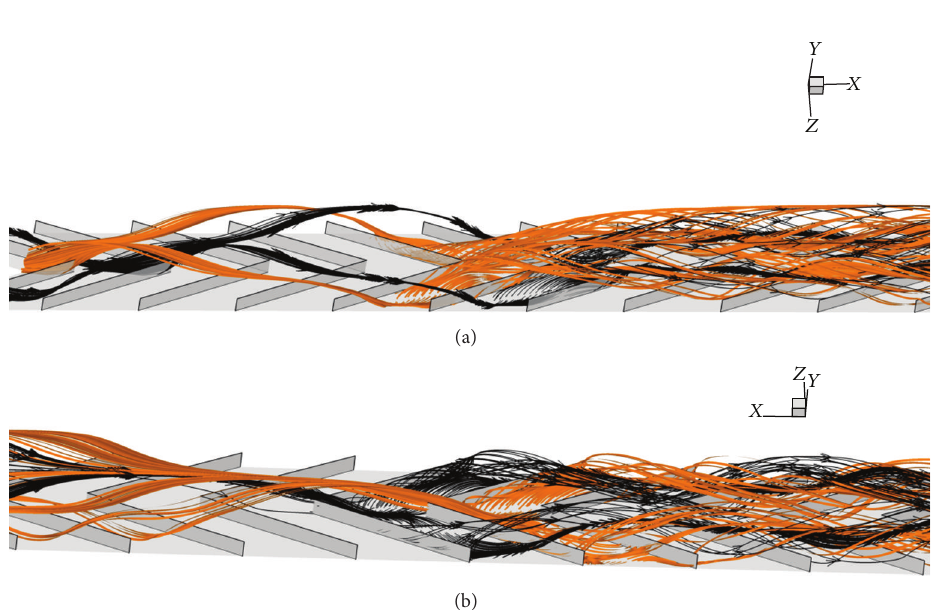
Figure 5: Streamlines impinging jet on the lower wall for (a) V-Downstream and (b) V-Upstream of 20 ∘ V-rib at Re = 800 , BR = 0.20 , and PR = 1